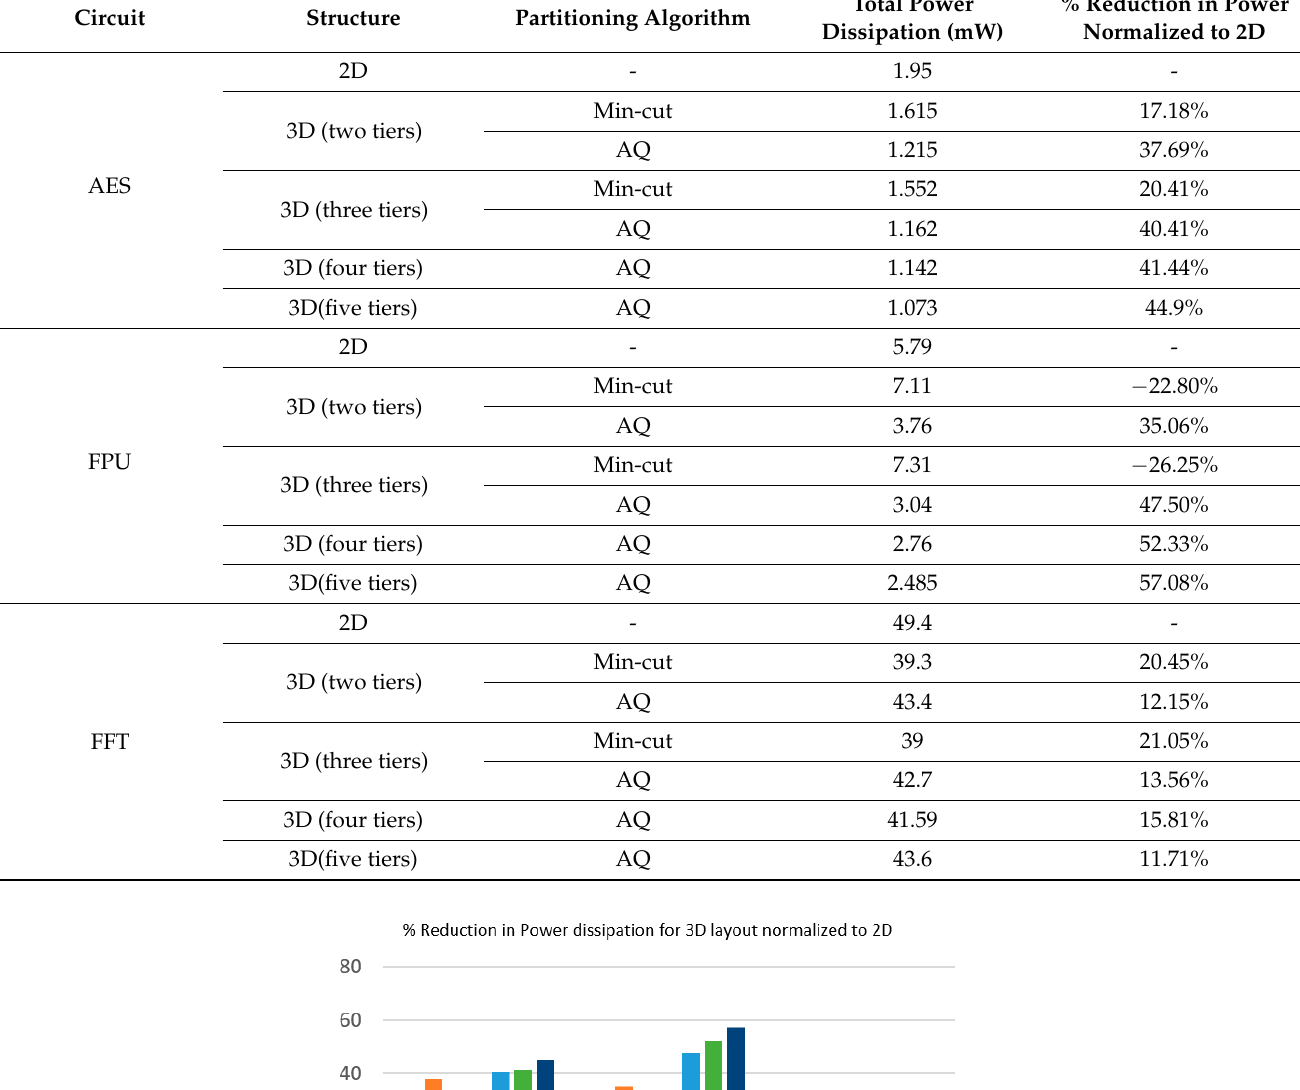
Table 2. Power dissipation results of benchmark circuits. The negative values in the “% Reduction in Power normalized to 2D” column represent an increase in the power dissipation.